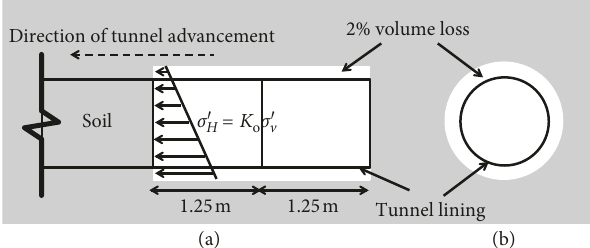
Figure 5: Schematic diagram of numerical modelling procedure. (a) Longitudinal view. (b) Cross-sectional